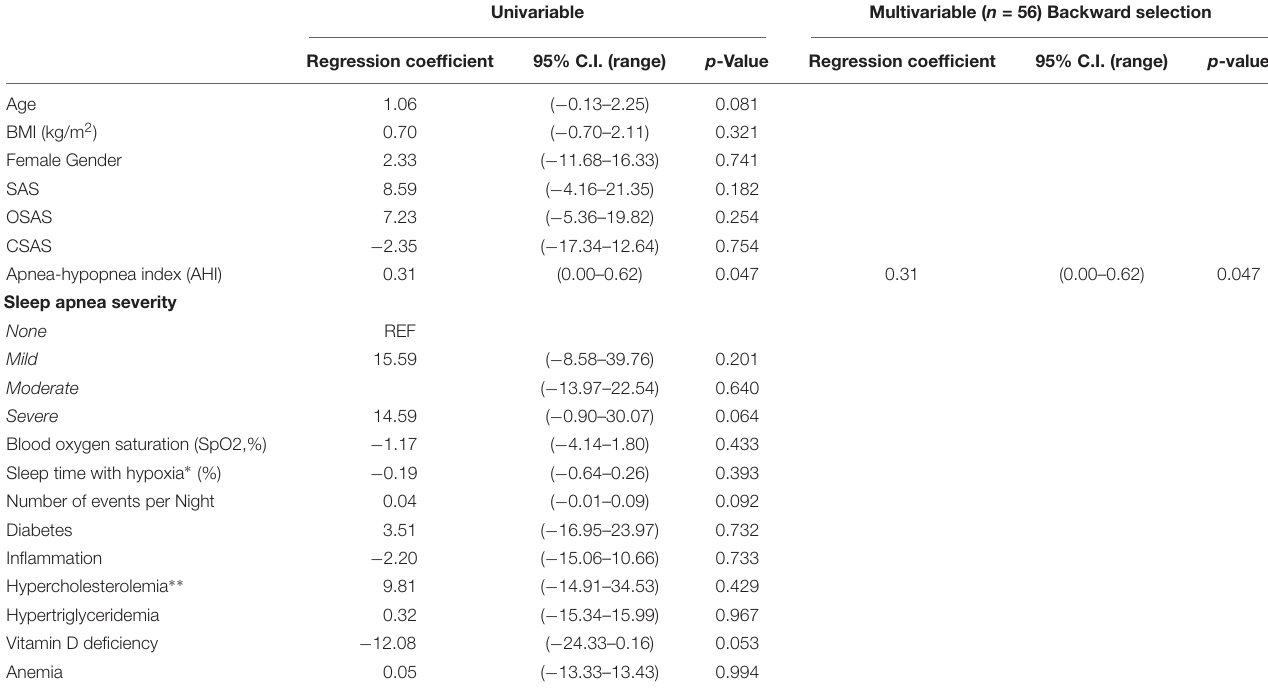
TABLE 7 | Uni- and Multi-variable regression to identify factors associated with the Stroop Words Test (delay, s). Univariable Multivariable ( n = 56) Backward selection